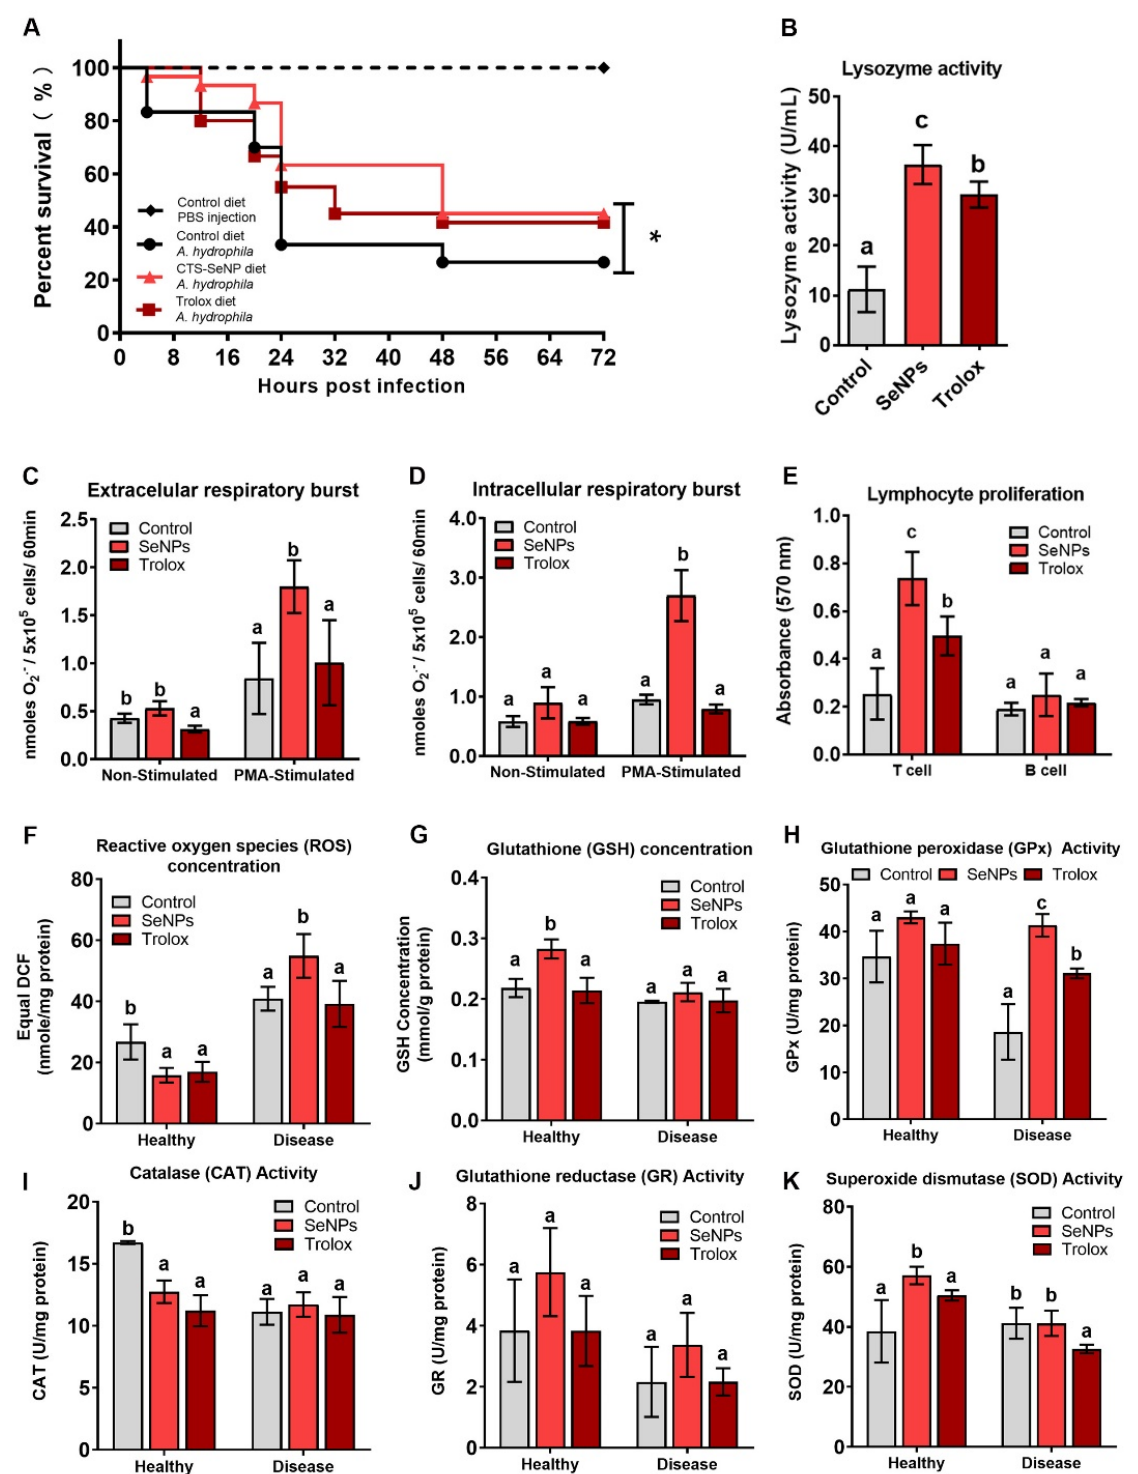
Figure 2. Dietary SeNPs and Trolox-induced immune and antioxidant responses: ( A ) Bacterial chal- lenge by Aeromonas hydrophila in the zebrafish fed with SeNP, Trolox or control diets; ( B ) Lysozyme activity; ( C ) Extracellular respiratory burst activity; ( D ) Intracellular respiratory burst activity; ( E ) Lymphocyte proliferation; ( F ) ROS concentration; ( G ) GSH concentration; ( H ) GPx activity; ( I ) CAT activity; ( J ) GR activity; ( K ) SOD activity. Different alphabets in the figure indicate statistically different groups where * p <